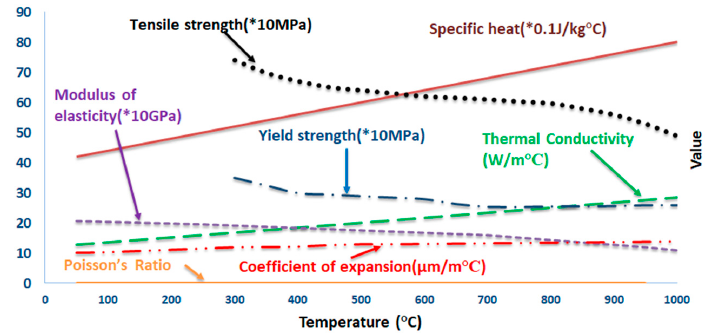
Figure 4. Physical and mechanical properties of Alloy 617.